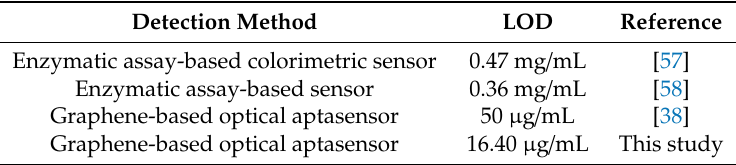
Table 4. Detection methods for GHSA used in previous